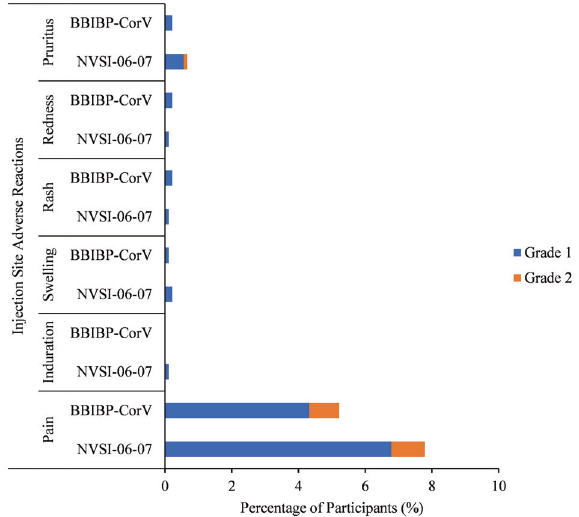
Fig. 3 Injection site adverse reactions reported within 7 days after injection of NVSI-06-07 or BBIBP-CorV. Adverse reactions are graded according to the scale issued by the China National Medical Products Administration (NMPA). Grade 1 is mild and grade 2 is